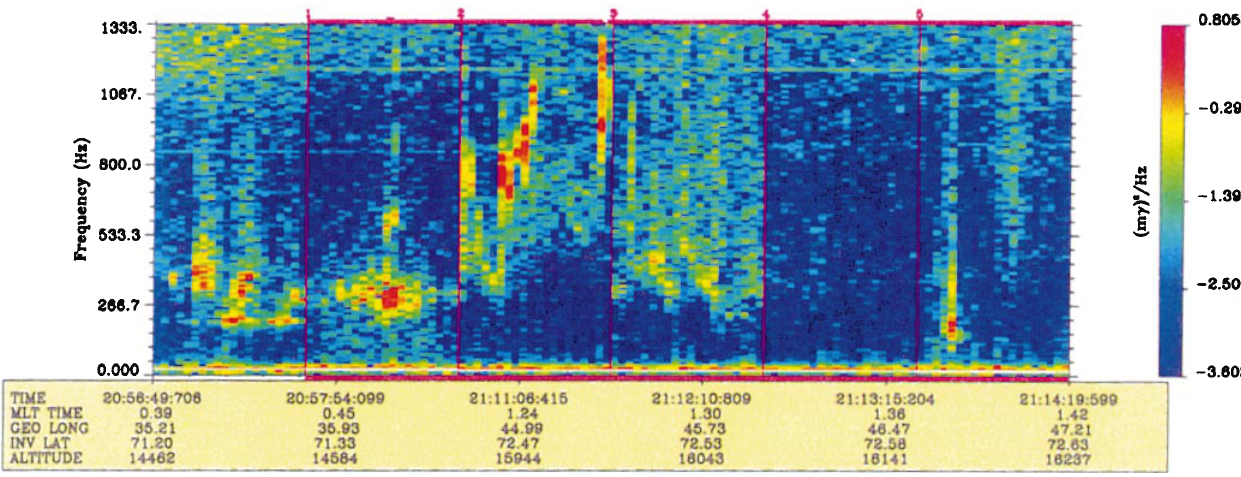
Fig. 10. Successive high resolution spectrograms of nightside burst of ELF electromagnetic emission (see text). The observation was made on 11